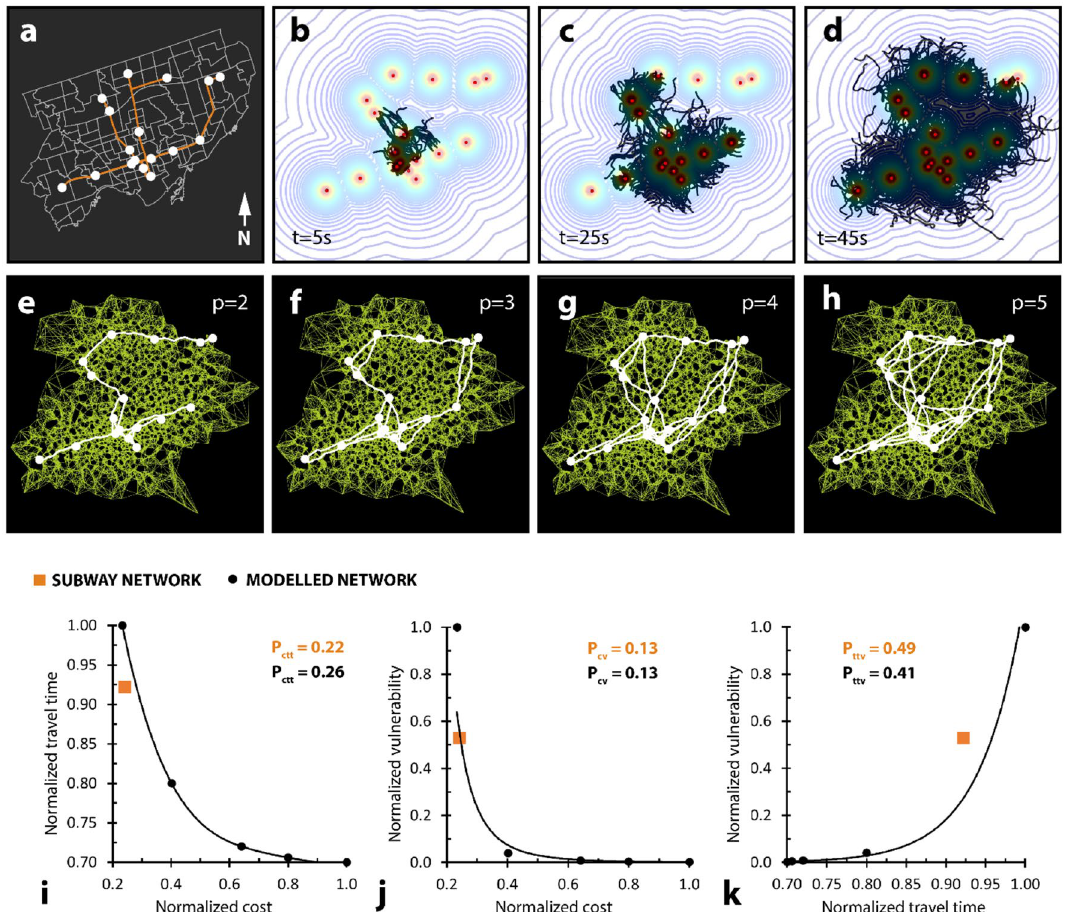
Figure 7. Built versus modelled subway network performance is varied. ( a ) Network to describe Toronto underground subway system. ( b – d ) Modelled growth to establish mesh to describe subway system. ( e – h ) Different shortest-walk calculations for the same mesh, generated from d, but with unique proximity coefficient values. ( i ) Plot relating network cost to travel time for both built (orange) and modelled (black) networks. Trendline is a fourth-order polynomial function. ( j ) Plot relating network cost to vulnerability for both built (orange) and modelled (black) networks. Trendline is a power function. ( k ) Plot relating network travel time to vulnerability for both built (orange) and modelled (black) networks. Trendline is an exponential function. All performance values normalized to the largest local value. Modelled performance values displayed on the plots represent performance for the closest modelled point to the built point (orange) along the